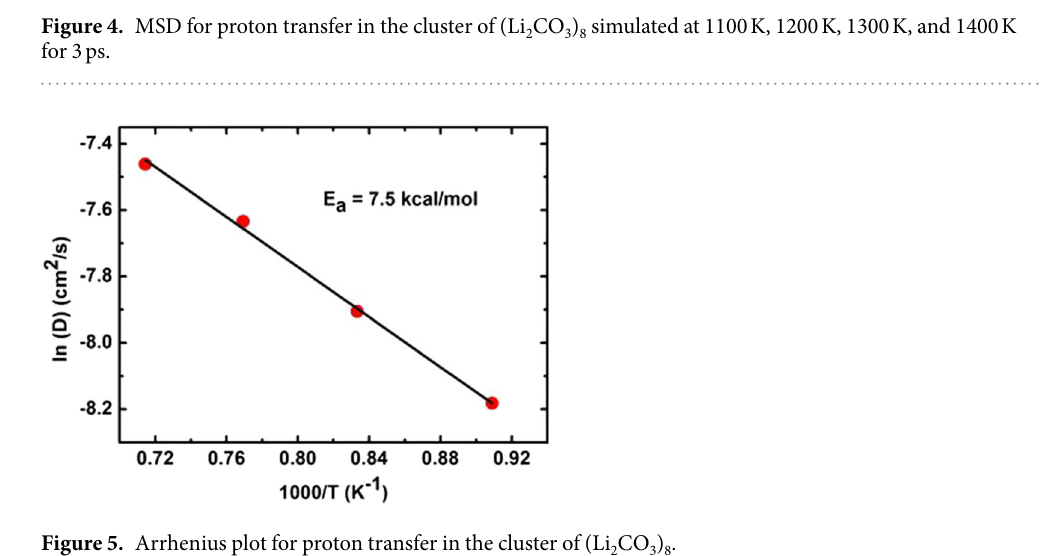
Figure 5. Arrhenius plot for proton transfer in the cluster of (Li 2 CO 3 ) 8